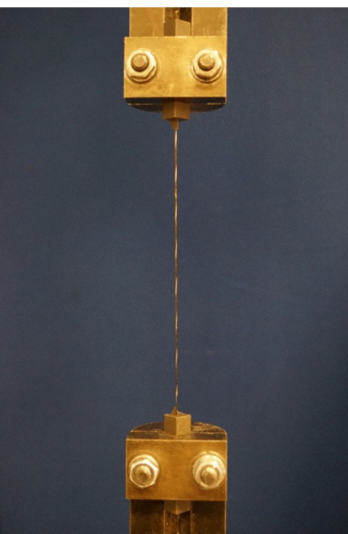
Figure 6. Experimental setup to determine the tensile strength of the